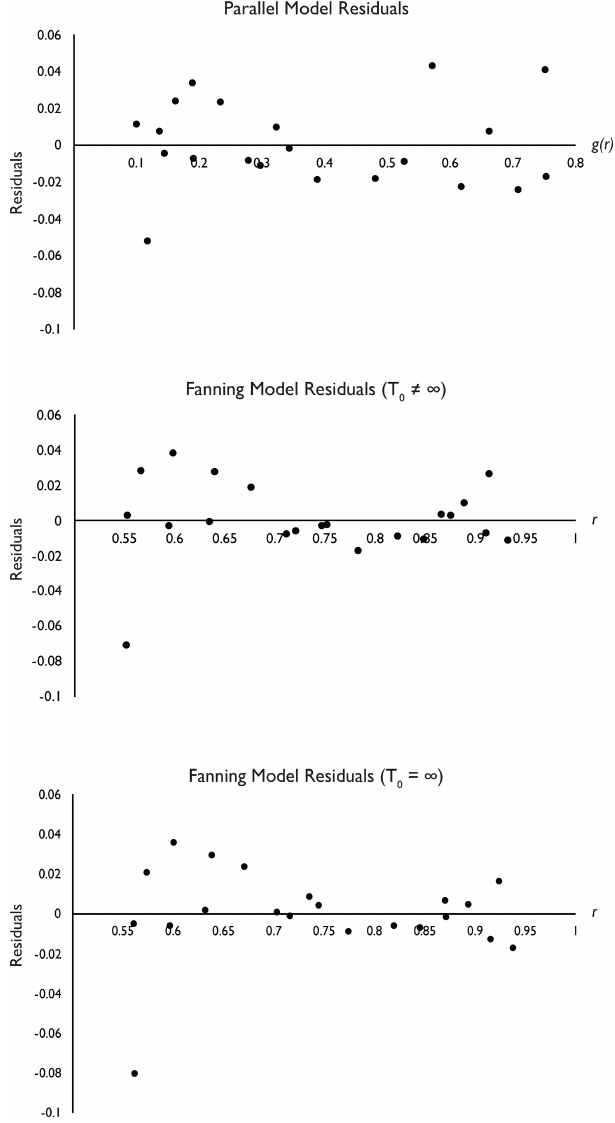
Figure 9. Residual plots for the best-fitting calculations for each model ( ε in Eqs. 3, 10 and 11). Each point represents one annealing